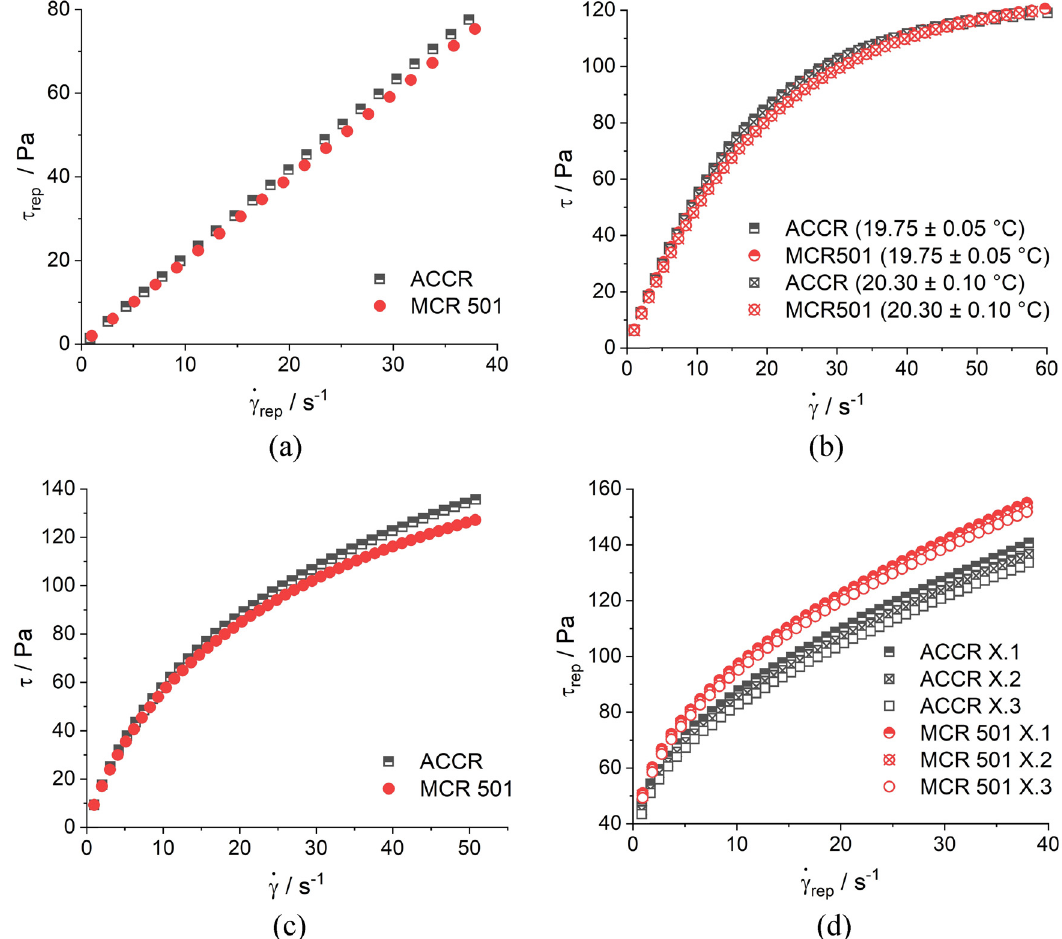
Figure 5: Flow curves measured with the ACCR and the MCR 501; ( a ) sugar solution with ω 0.74 m = ; ( b ) cream bath; ( c ) suspension consisting of cream bath and polyamide particles with ϕ 0.3 ; and ( d ) mayonnaise ( mean values of the associated individual measurements are PA = marked as X.1, X.2, and X.3 )